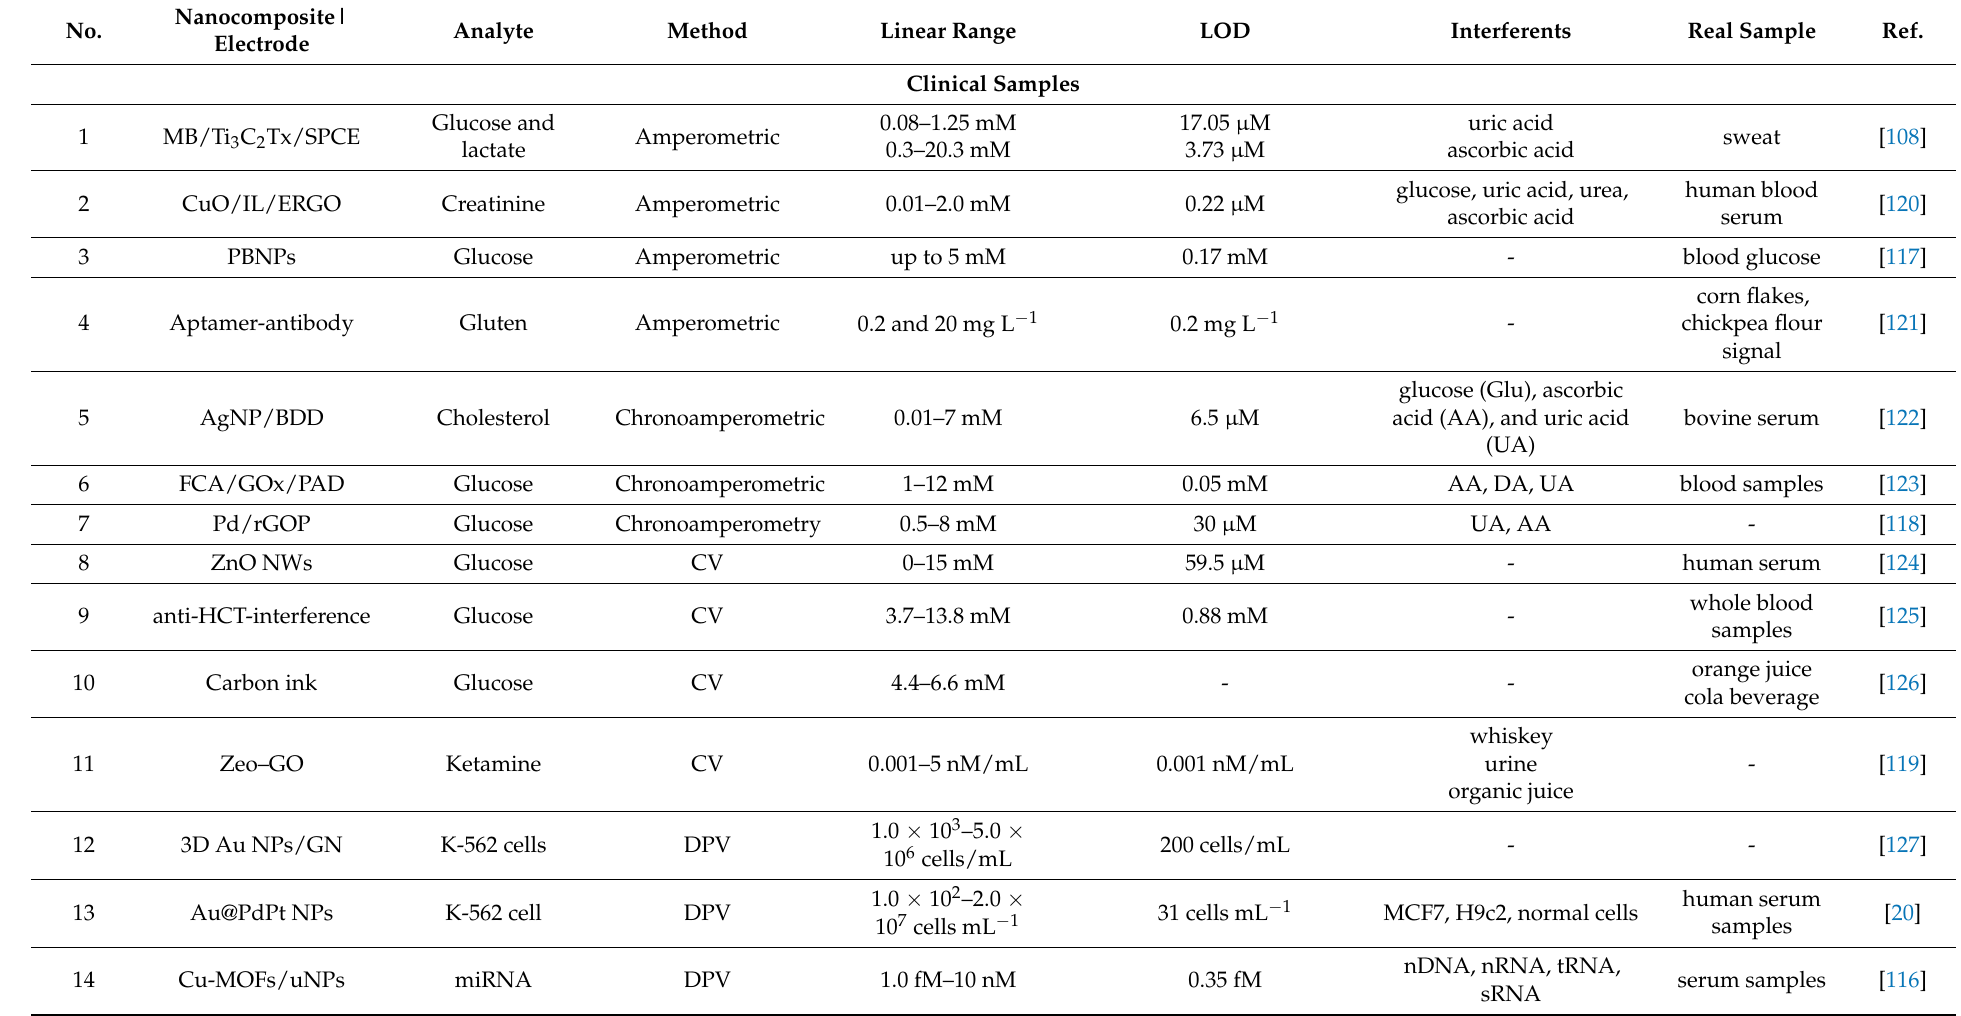
Table 2. Paper-based electrochemical sensors for clinical and environmental